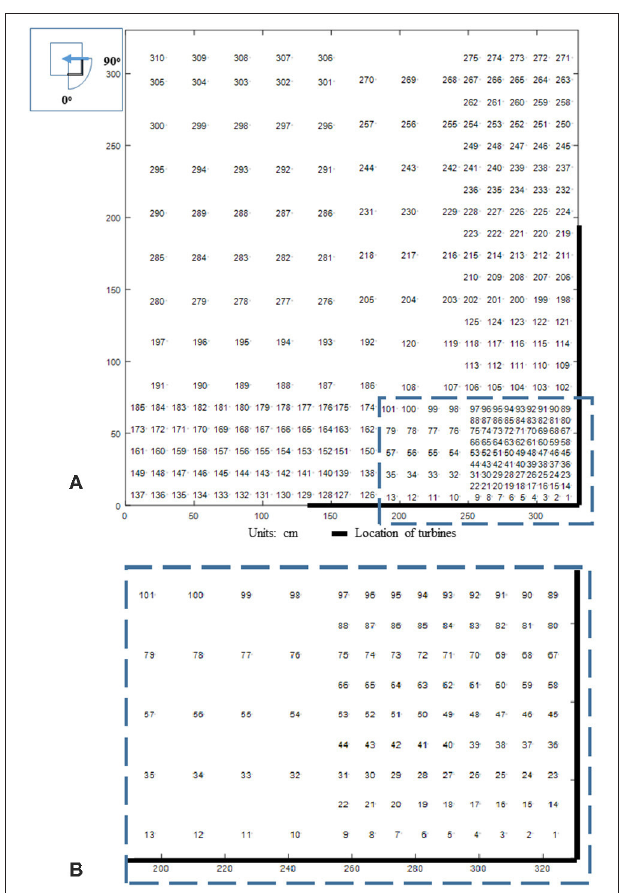
FIGURE 2 | Tap layout on the roof and the range of wind directions tested (A) entire roof area (B) magnified view of the corner.